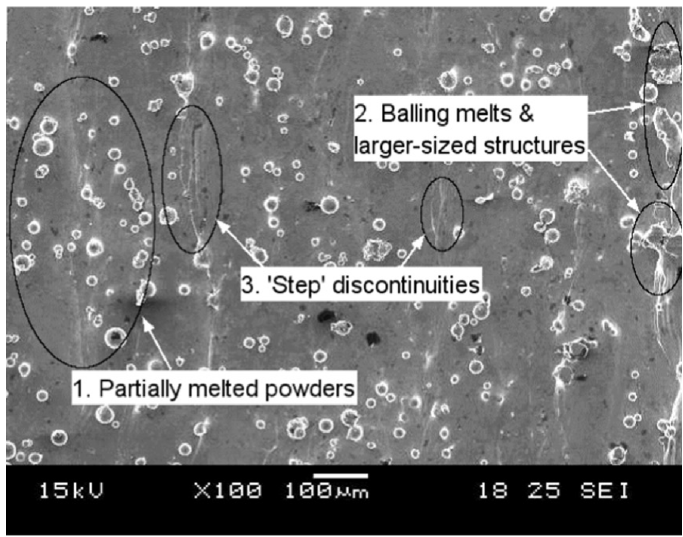
Figure 16. Defects that can occur in metal powder bed following AM [37].